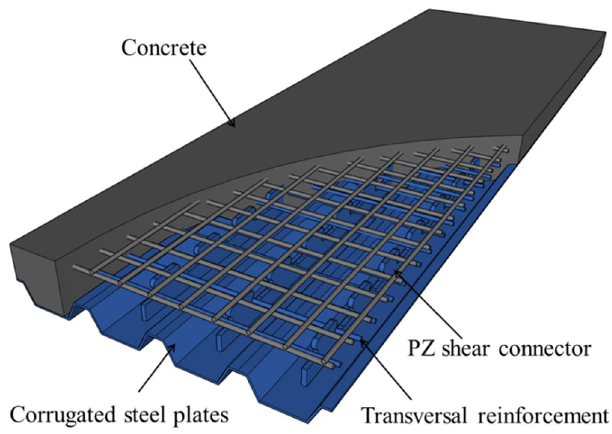
Figure 1. Schematic diagram of corrugated steel–concrete composite bridge decks.